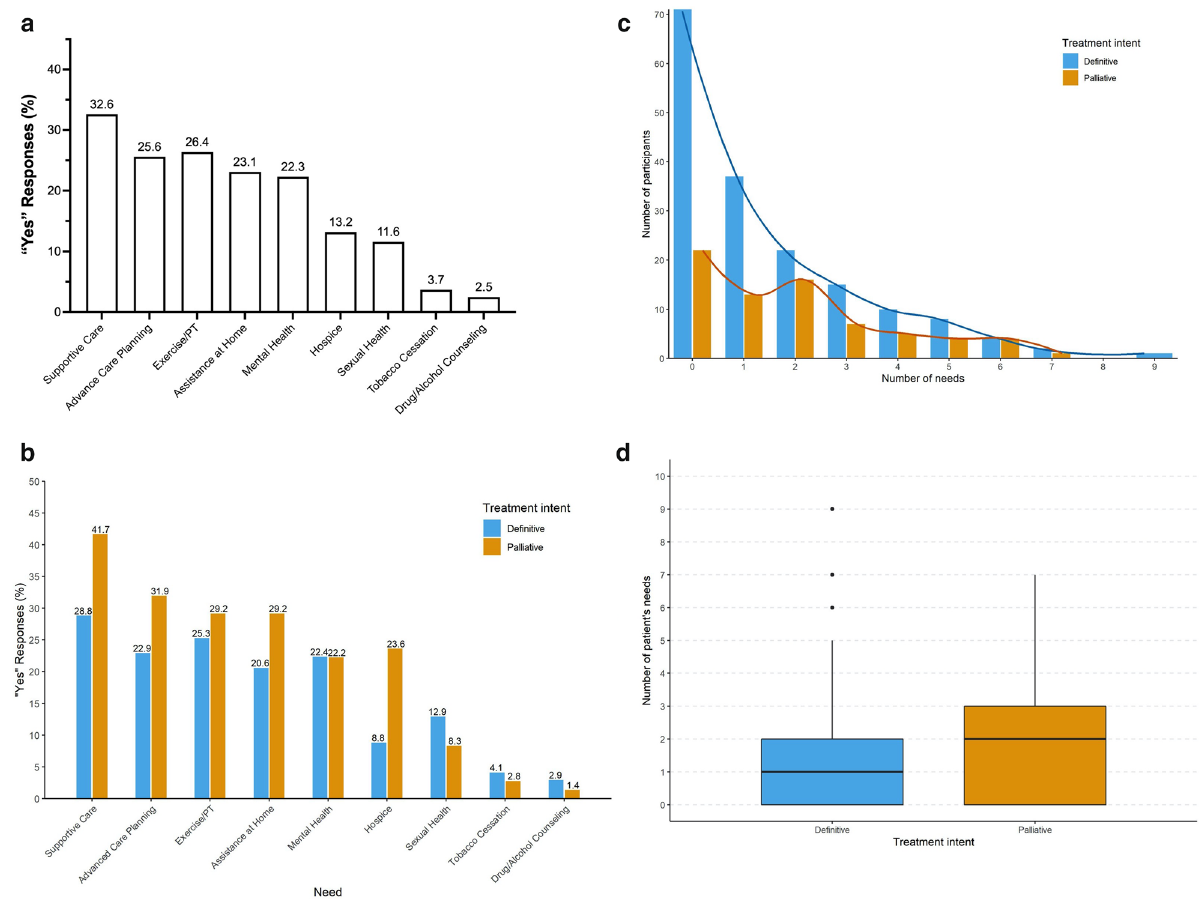
Figure 1. Summary of patient needs. Summary of identified survey needs for ( a ) all participants and ( b ) by treatment intent. ( c ) Number and ( d ) distribution of the number of patients’ needs by treatment intent. Based on negative-binomial statistical model, there is no evidence for difference in mean number of needs between the two groups of participants (p-value =